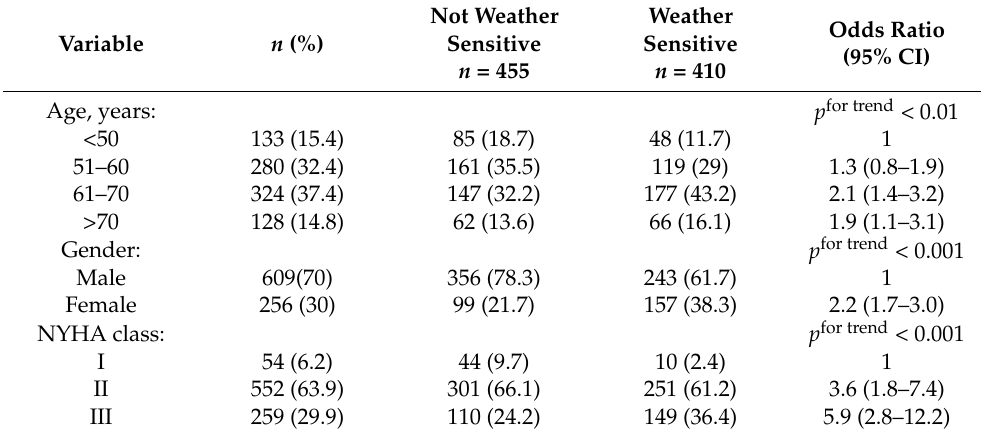
Table 1. Demographic and clinical characteristics of all patients at inclusion and stratified by self- report weather